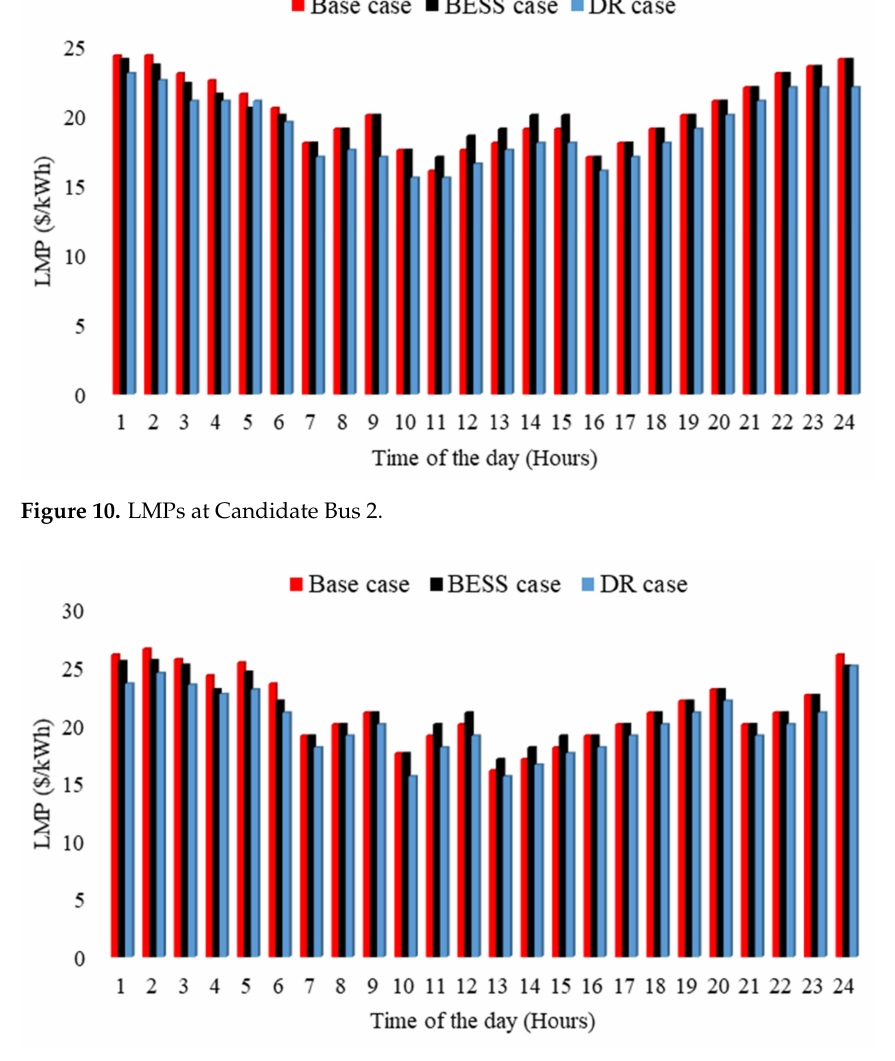
Figure 11. LMPs at Candidate Bus